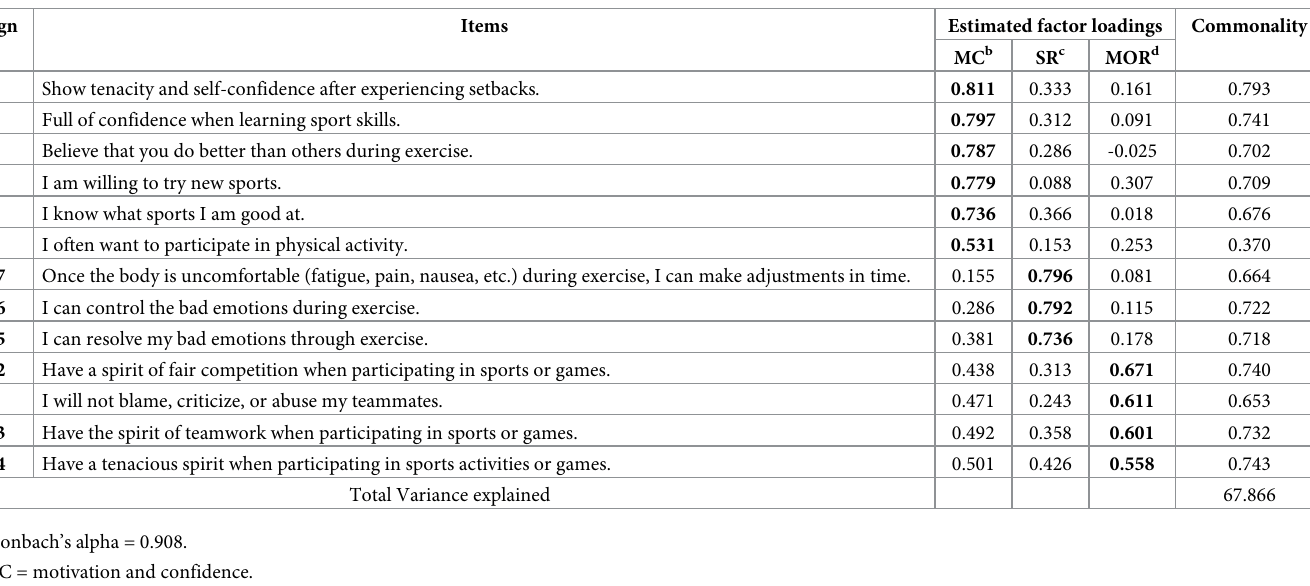
The concept, framework and measurement of PL show pluralistic characteristics in the world. Although different countries and organizations have different understandings of PL, and have proposed different versions of the definition, framework and measurement of PL, the Table 8. Factor structures of affective domain by exploratory factor analysis a .